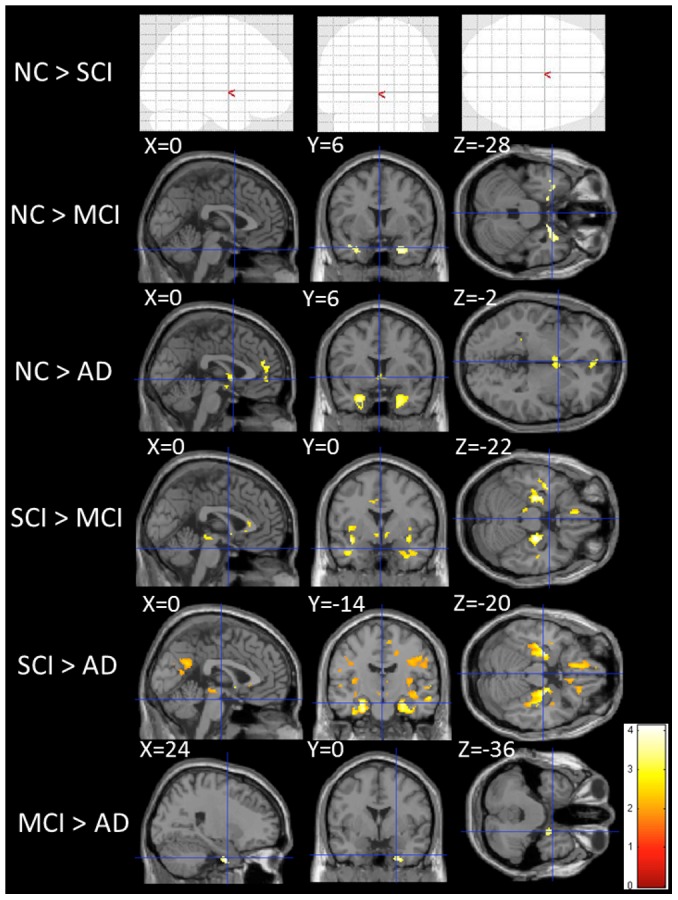
Gray matter atrophy across subjects groups.Voxel-based analysis showing regions of gray matter atrophy across groups. Clusters are overlaid on the MNI standard brain. Red- to yellow-colored voxels show regions with significance in the analyses. The blank brain map (NC > SCI) shows that there are no significant differences between NC and SCI groups.